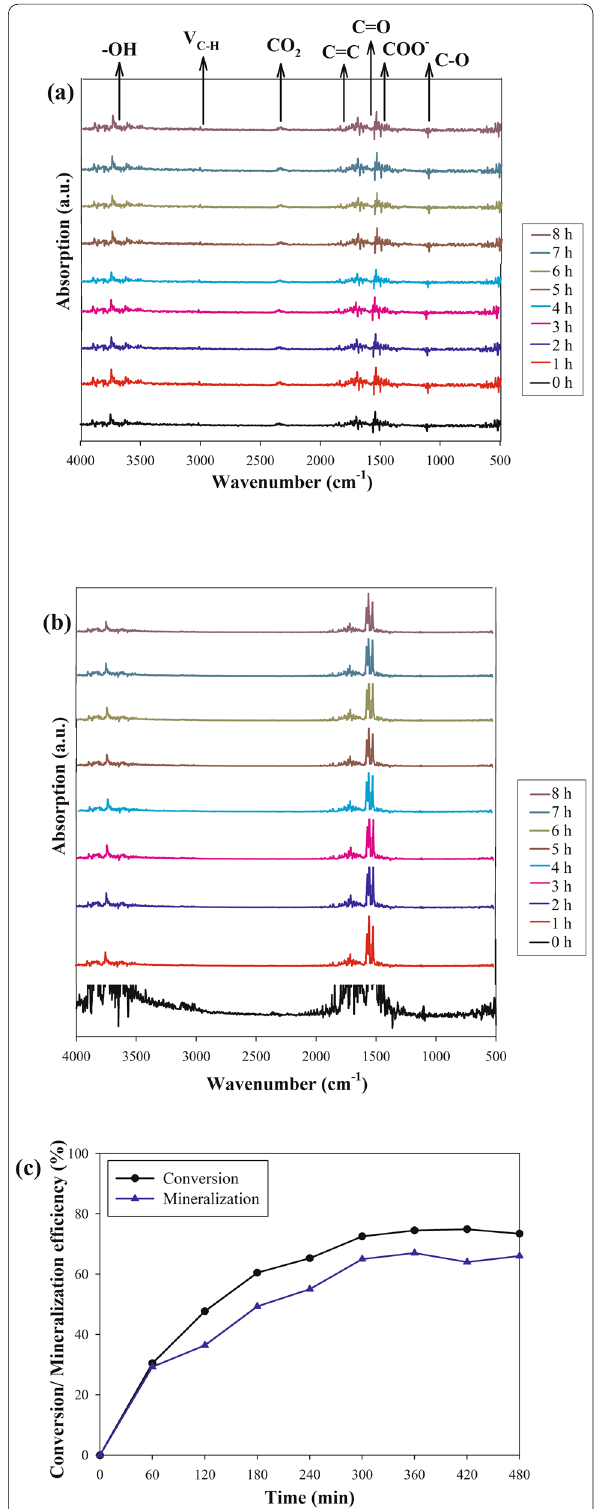
Fig. 9 Byproducts FTIR spectra under ( a ) 0% or ( b ) 60% RH, and ( c ) mineralization